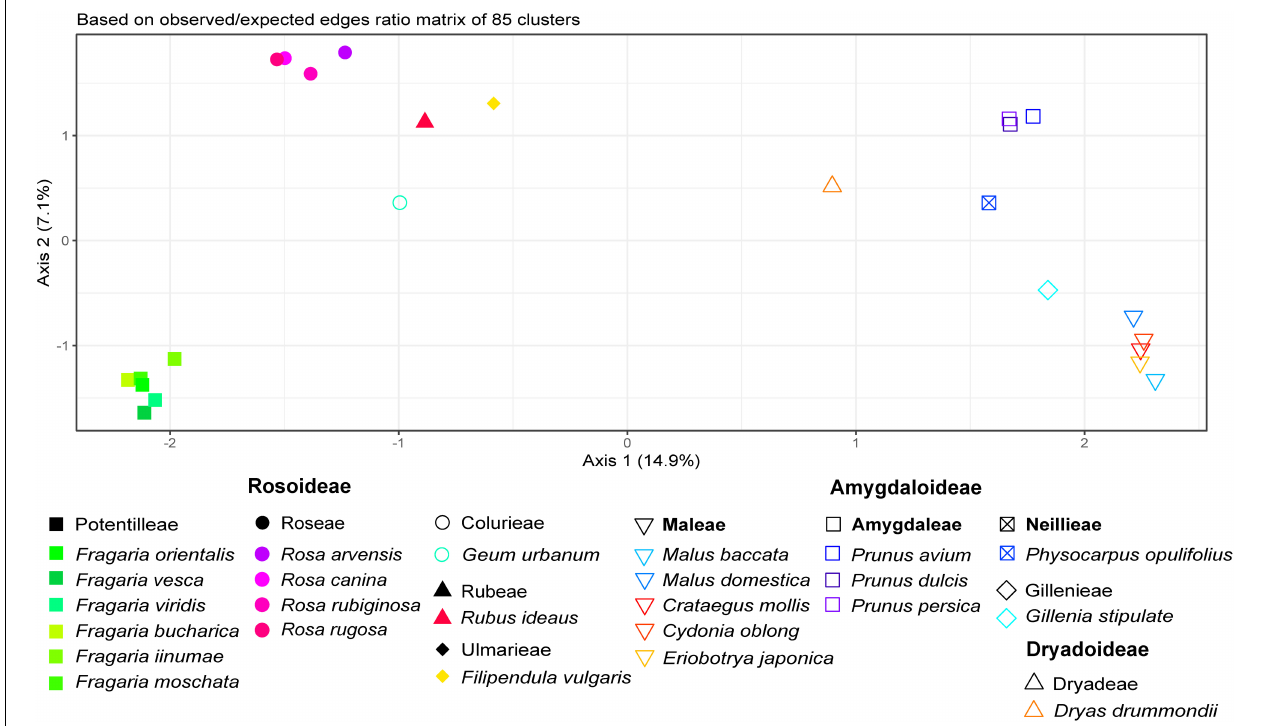
FIGURE 3 | Principal Coordinate Analysis of Rosaceae species based on 85 remaining inverted and summarized observed/expected matrices from the comparative RepeatExplorer2 output after removal of matrices containing NAs. Axis percentages explain the variance on the first two dimensions. Colors represent species and symbols taxonomic